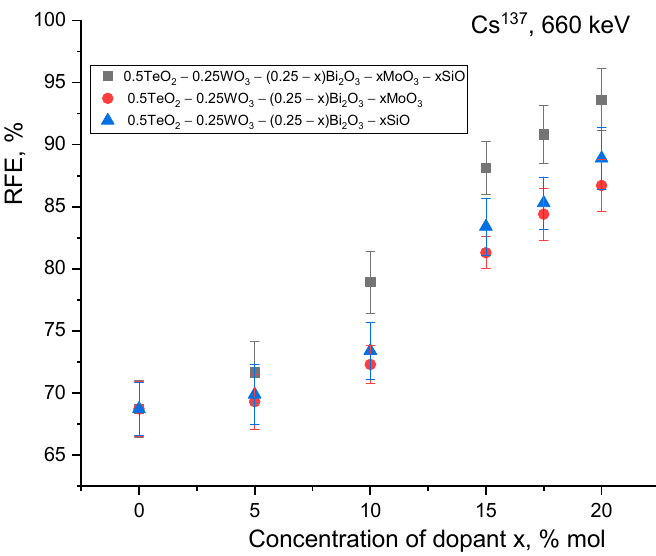
Figure 10. Results of RFE calculations depending on glass thickness 1.0 mm.